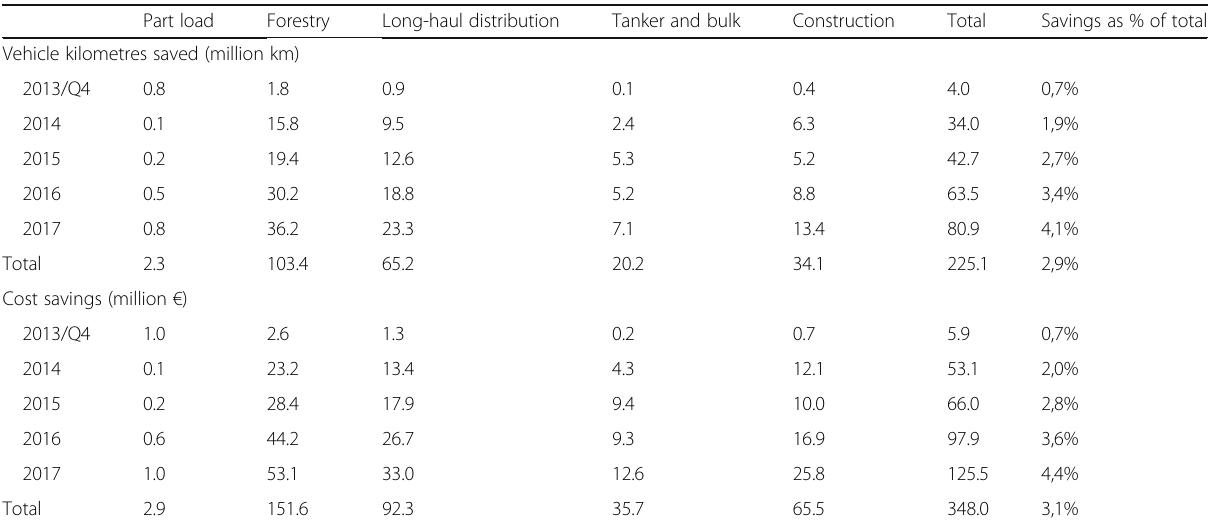
Table 5 Cost savings of using HCVs in 2013 – 2017 Part load Forestry Long-haul distribution Tanker and bulk Construction Total Savings as % of